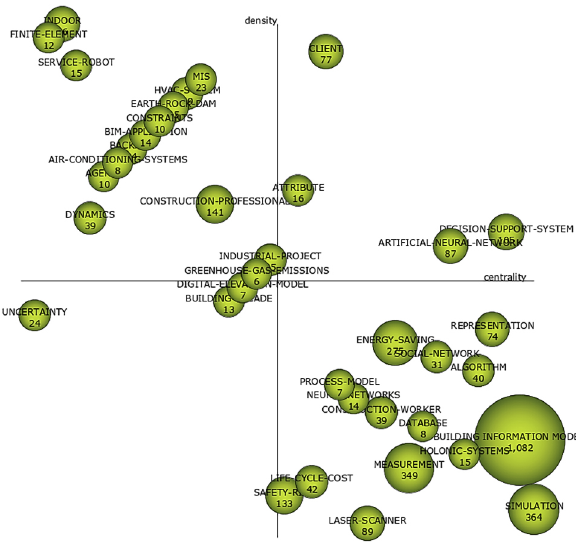
Figure 8. The strategic diagram of the sub-period Table 10. Performance measures of themes